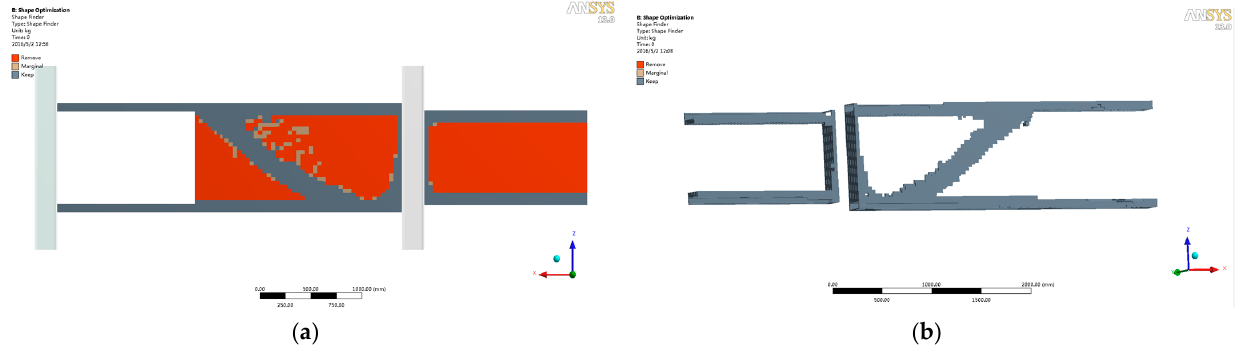
Figure 12. Topology optimization results for torsional conditions. ( a ) Top face; ( b ) Retained fraction with density of 1.